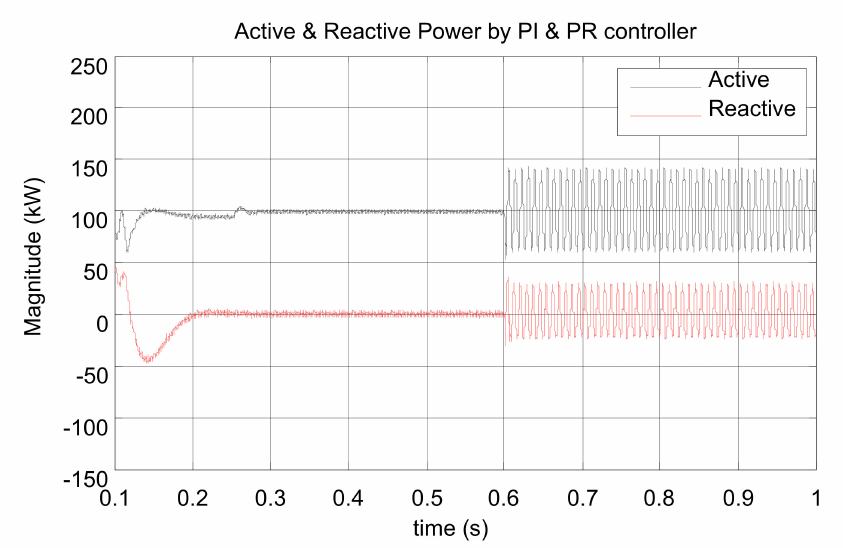
Figure 18. Injected instantaneous power into the grid via the conventional method.